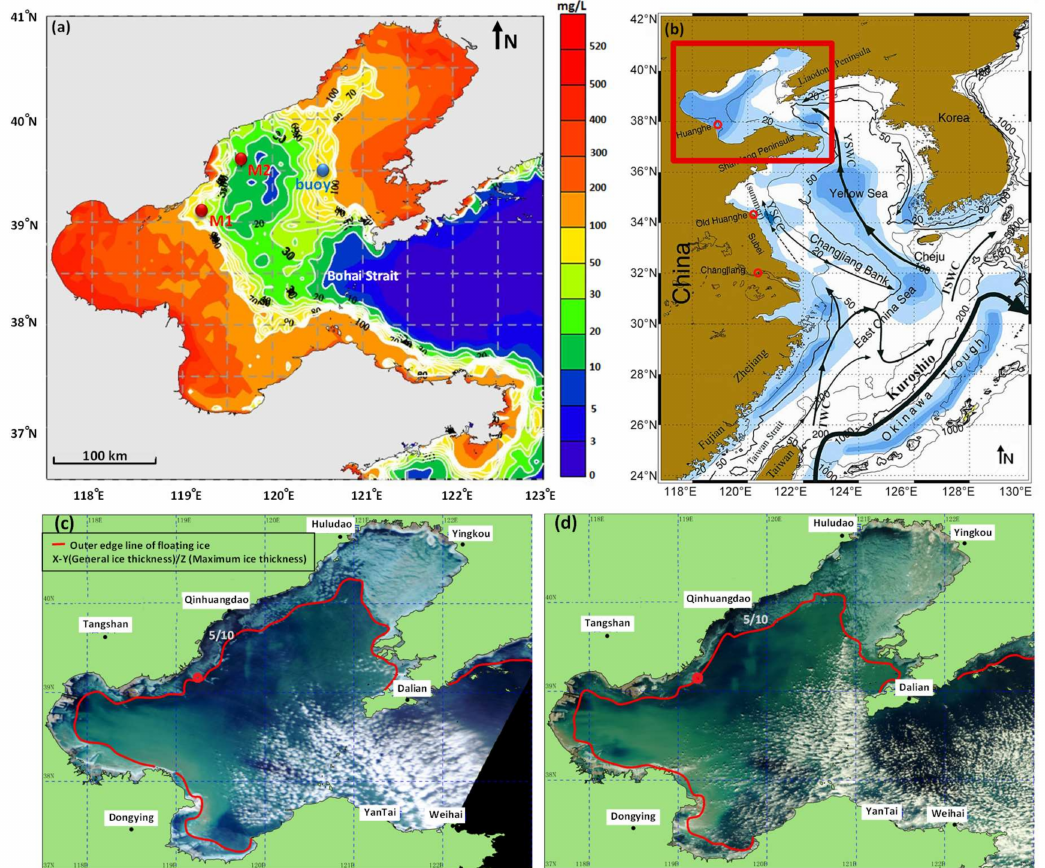
Figure 1. The position of Bohai Sea and its distribution of average surface suspended sediment concentration in winter, as well as sea ice information. ( a ) Distribution of average surface suspended sediment concentration in winter in the Bohai Sea in 1998–2004 retrieved from ocean color remote sensing inversion [31]. The red circles are the in situ observation stations for flow and sediment, which are stations M1 and M2, respectively. The blue circles are the o ff shore buoys used to measure sea surface wind speed. ( b ) The position of the Bohai Sea [32]. ( c , d ) Sea ice images of the study area on 29 January 2018 and 5 February 2018, respectively, contain the ice cover area and ice thickness information, which were downloaded from the National Marine Environmental Forecasting Center